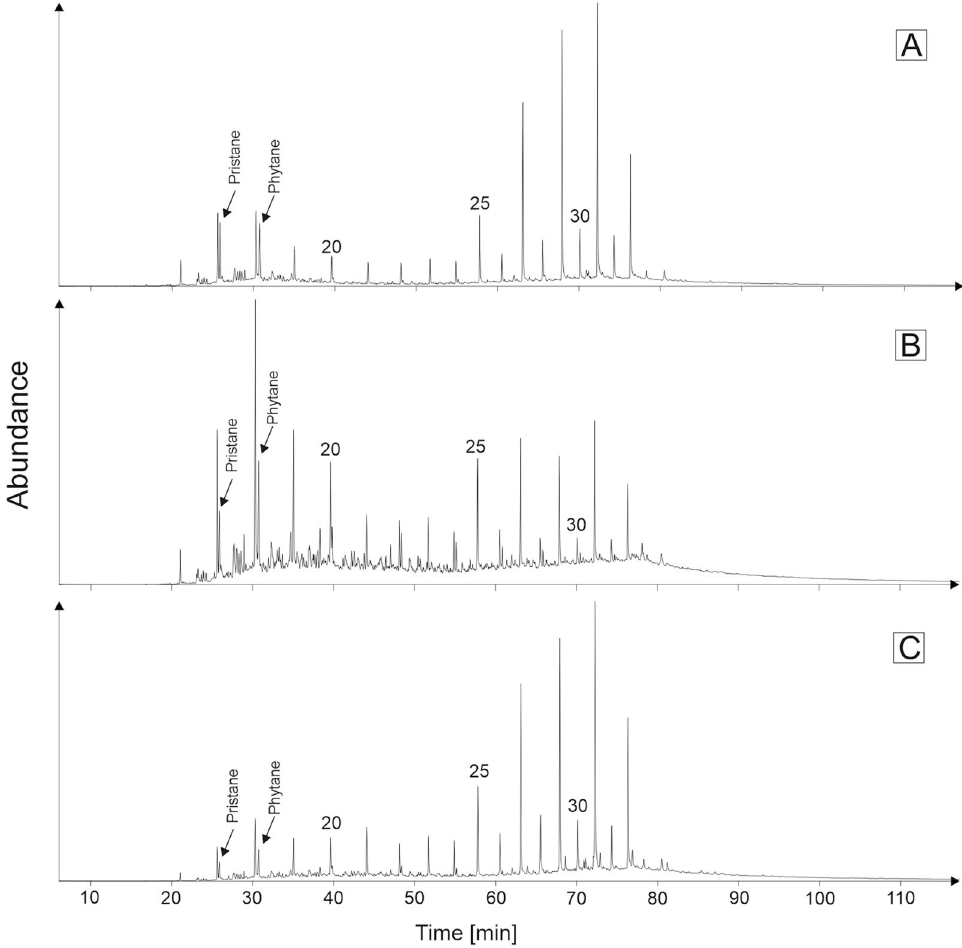
Figure 10. Mass chromatograms ( m/z 71) saturated hydrocarbon fractions, ( A ) LC1 sample, ( B ) SC1 sample, and ( C ) SC4 sample. 20, icosane; 25, pentacosane; 30, triacontane.